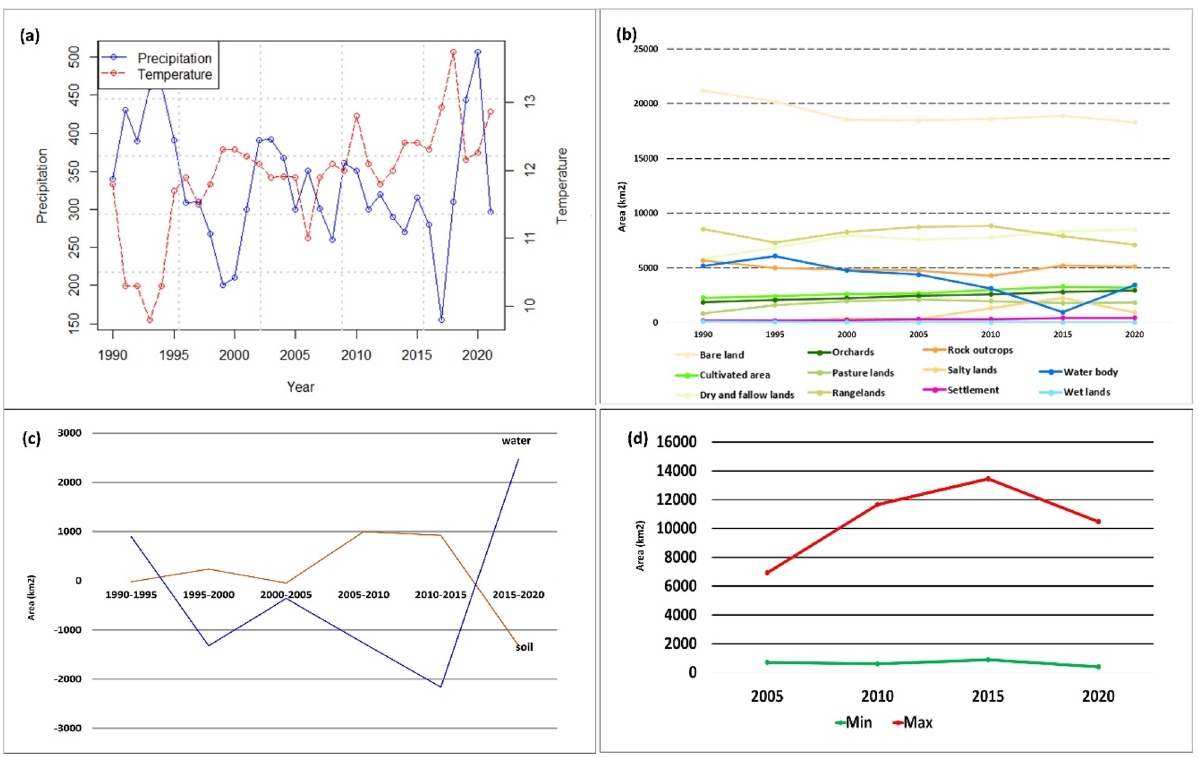
image analysis from 1990–2020, ( c ) time series analysis of changes in the soil salinity and water body of the lake and the extension of soil salinity in the past three decades, and ( d ) time series assessment of groundwater salinization from 2000 to